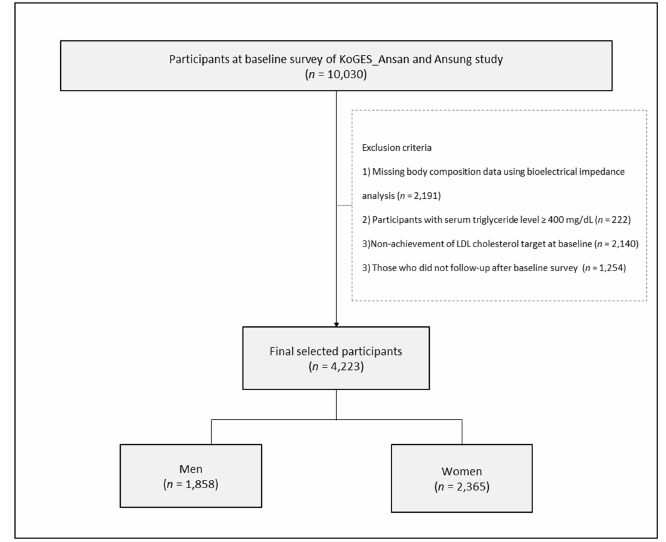
Figure 1. Flow chart of the study population selection process.